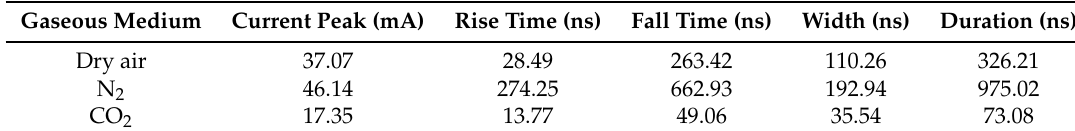
Table 1. Positive polarity current pulses characteristics.